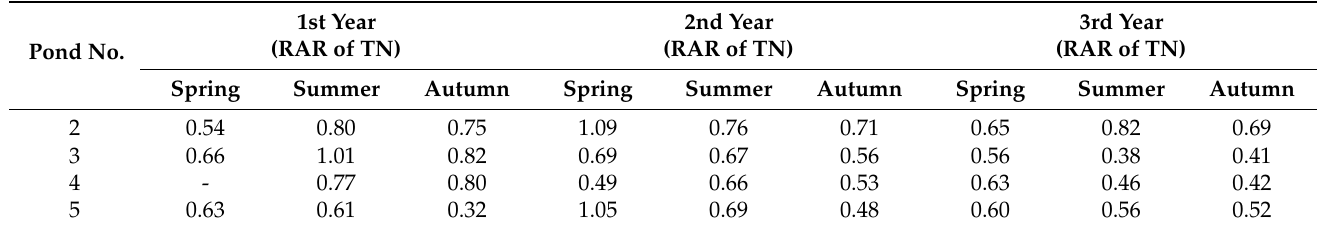
Table 7. Statistics of the RAR of the quarterly average TN value 1 at each